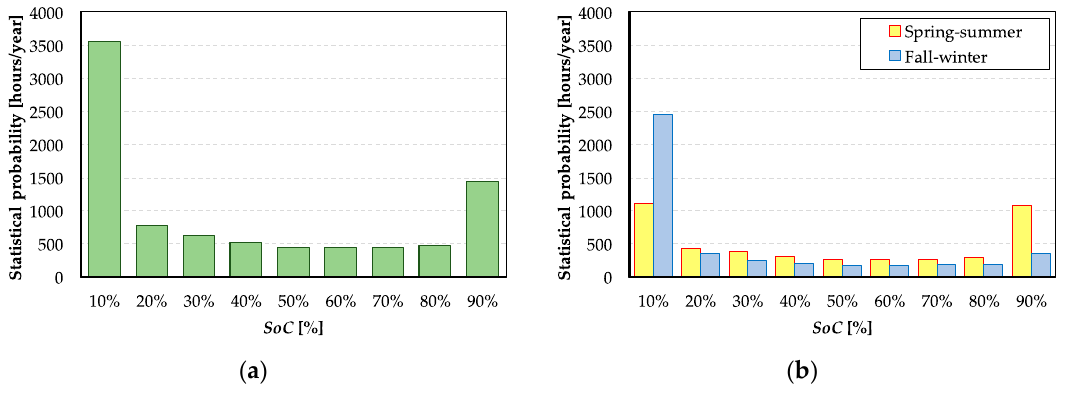
Figure 9. State of charge. ( a ) Yearly statistical distribution; ( b ) Statistical distributions considering the spring-summer period and the fall-winter period. Table 6. Monthly trend of representing parameters SSR , SCR , and MSF in Scenario B and in Scenario C (all of these parameters are dimensionless), related to monthly data of load consumption and PV energy injected in the DC bus.